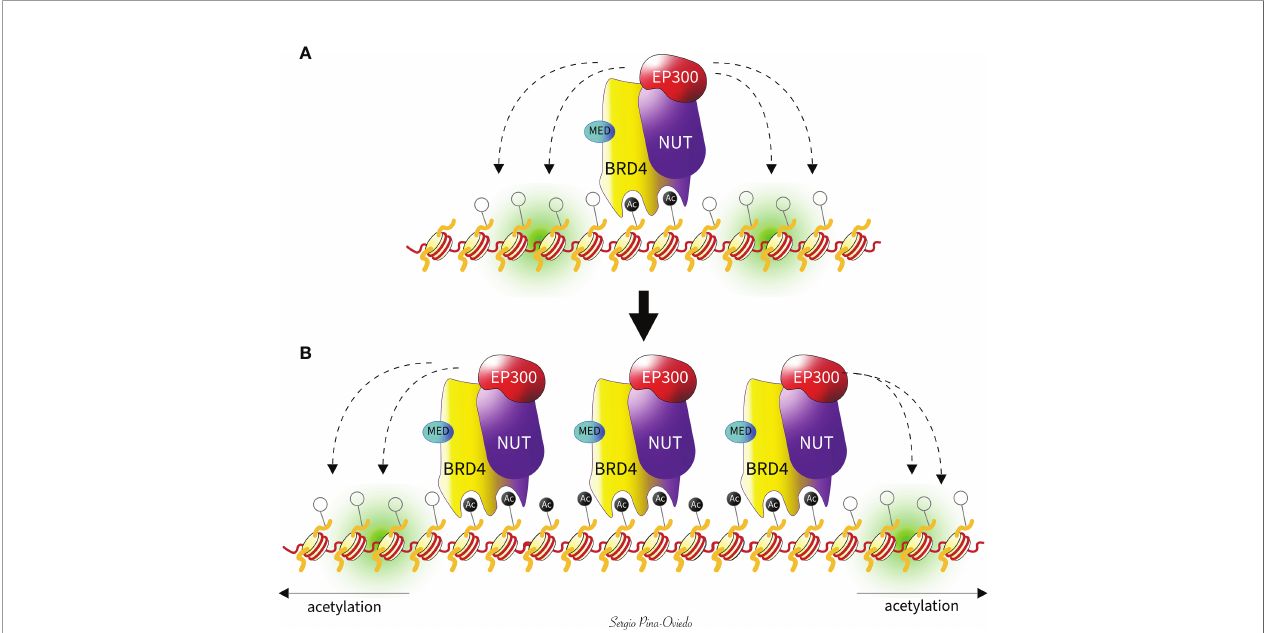
FIGURE 3 | Feed-forward model of megadomain formation. (A) BRD4-NUTM1 is tethered to acetylated chromatin by BRD4 bromodomains. EP300 is recruited by the NUTM1 portion of the fusion, leading to increased local histone acetylation and, subsequently, (B) a self-perpetuating recruitment of BRD4-NUTM1 complexes. The resultant uncontrolled spreading of BRD4-NUTM1 within the chromatin leads to the formation of megadomains that are typically limited only by topologically associating domain boundaries (not shown). The Mediator subunit 24 (MED) interacts physically with BRD4 as a target and a cofactor of BRD4-NUTM1, to provide another positive reinforcement loop for the establishment of megadomains and their transcriptional